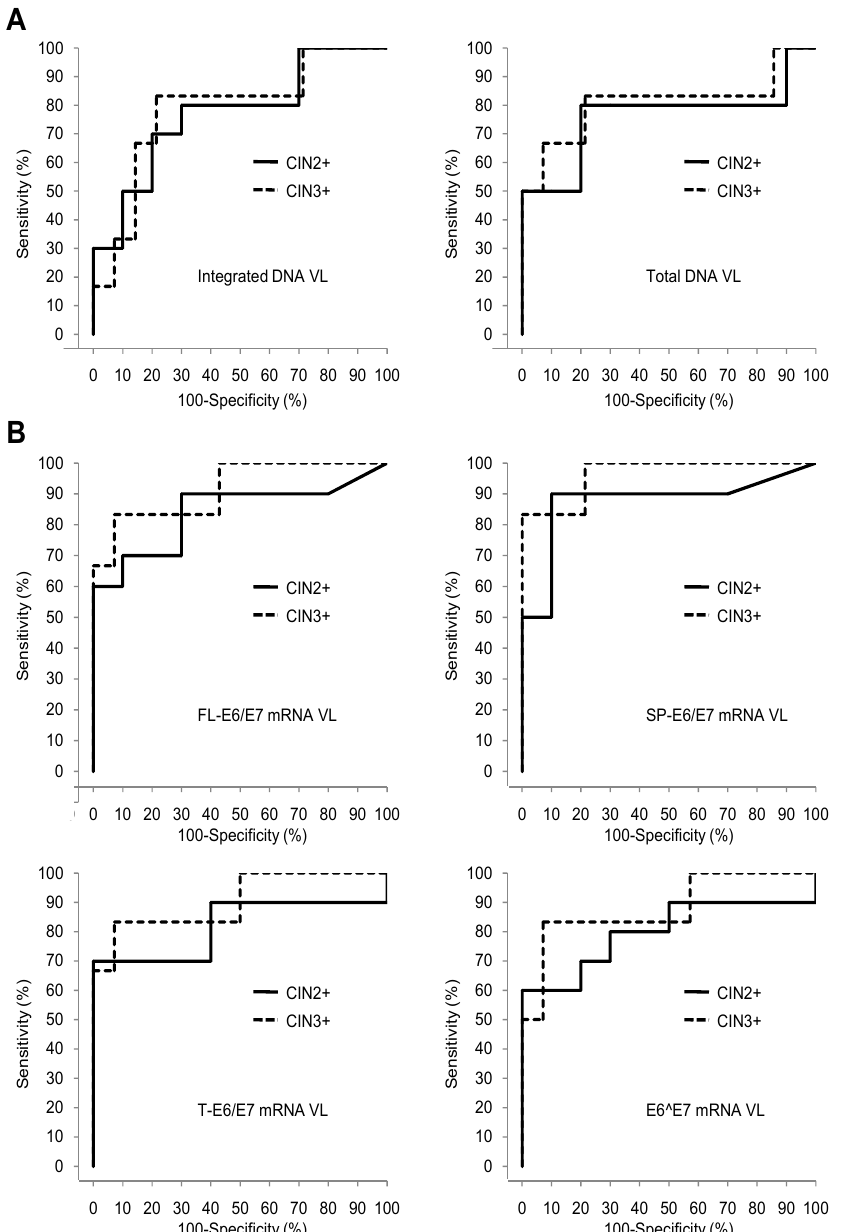
Figure 2. Receiver Operating Characteristic (ROC) curve analysis of human papillomavirus (HPV) 16 DNA and E6/E7 mRNA viral load (VL) quantification assays for classification of CIN2+ and CIN3+ lesions. ( A ) ROC curves obtained from analysis of integrated (left-hand panel) and total (right-hand panel) DNA VL data. ( B ) ROC curves obtained from analysis of FL-E6/E7 (top left-hand panel). SP-E6/E7 (top right-hand panel). T-E6/E7 (bottom left-hand panel) and E6ˆE7 (bottom right-hand panel) mRNA VL data.